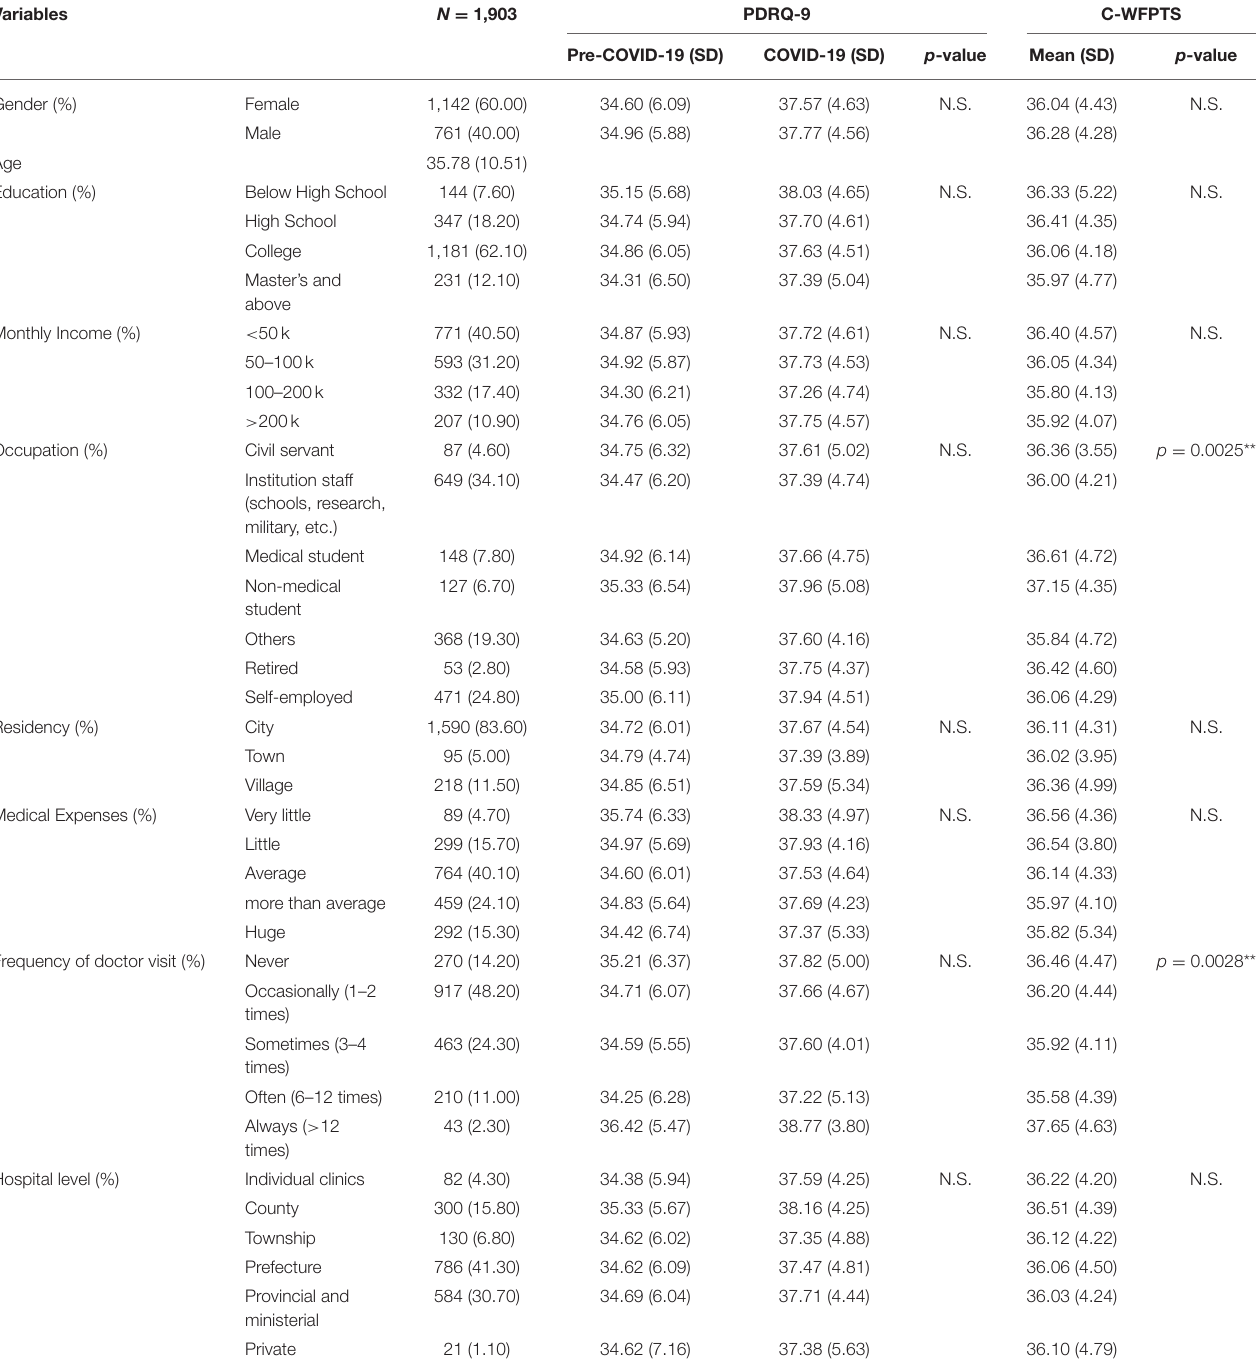
TABLE 1 | Sample characteristics and doctor–patient relationship